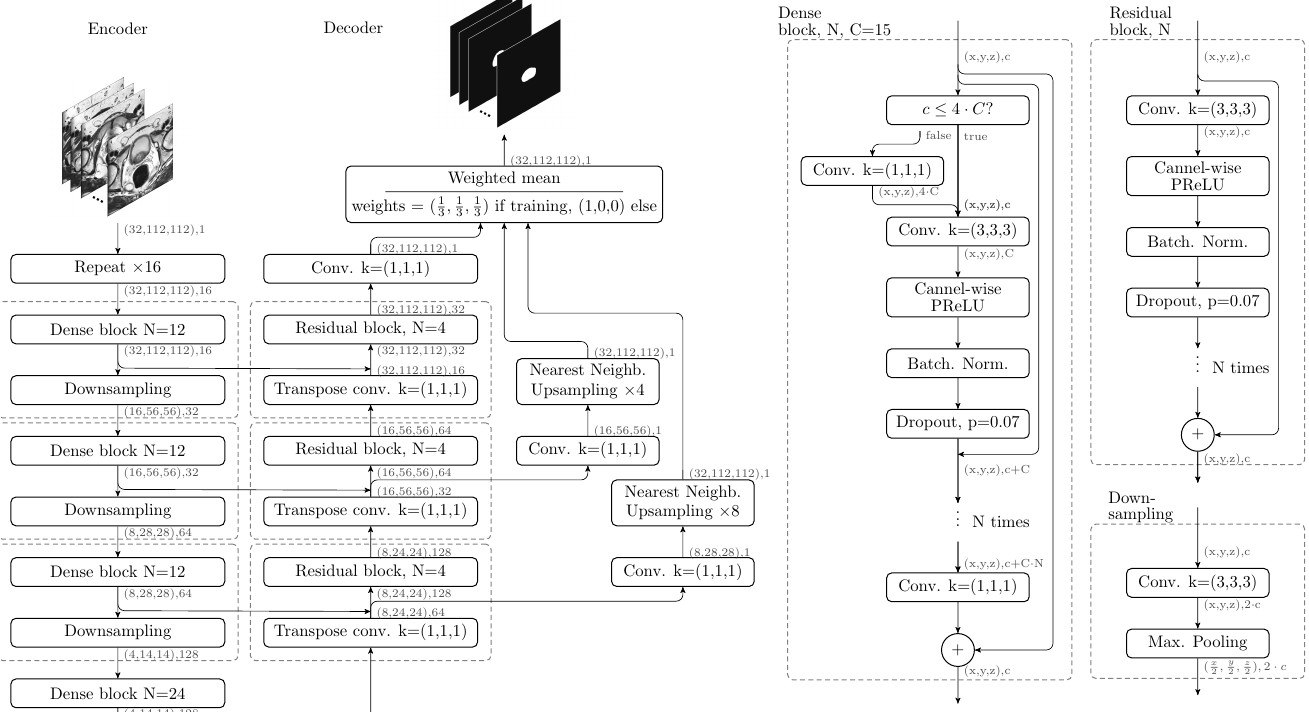
Figure 2. Architecture of the CNN. The encoder is composed of four Dense Blocks connected by Downsampling blocks. The decoder uses three Residual Blocks connected by transpose convolutions. Several skip connections transfer information from the encoder to the decoder. Furthermore, to the right of the decoder, intermediate outputs are used to perform Deep